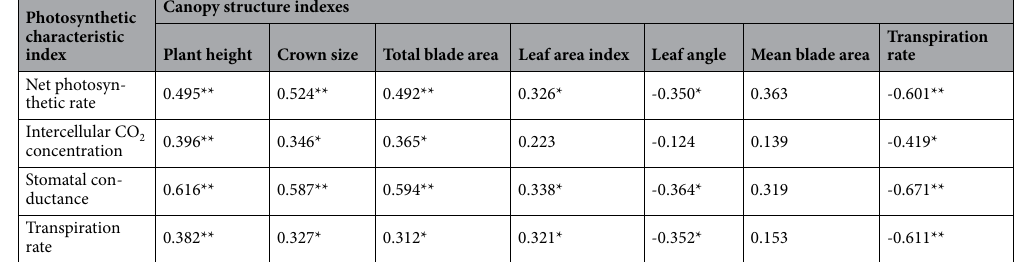
Photosynthetic characteristic